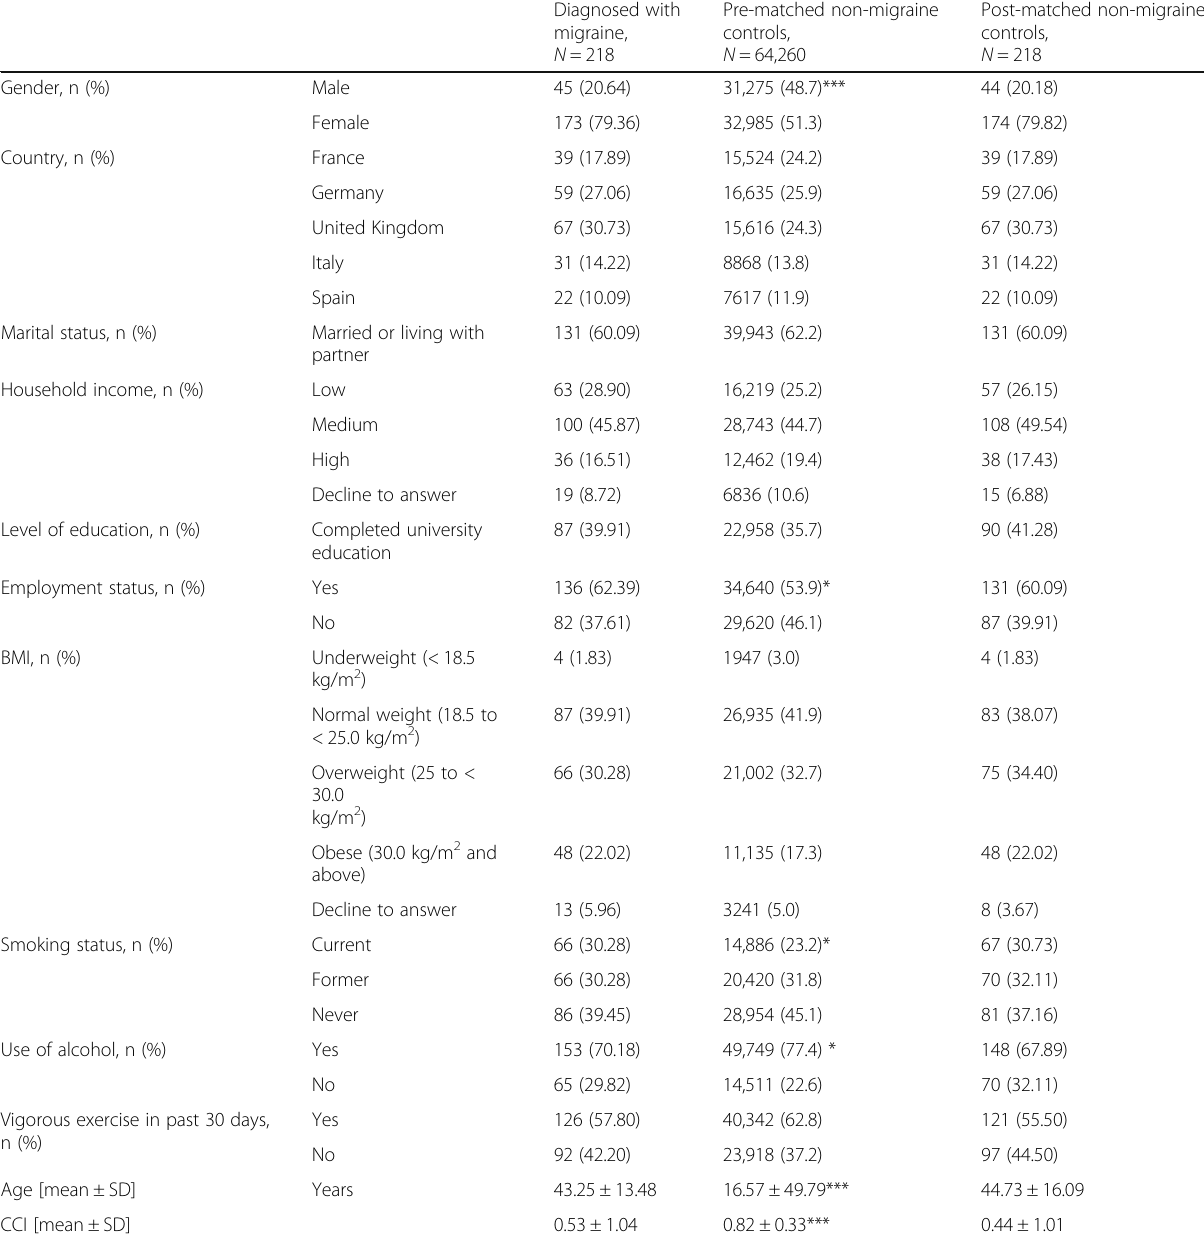
Table 1 Demographic characteristics for respondents diagnosed with migraine and pre-matched and post-matched non-migraine controls